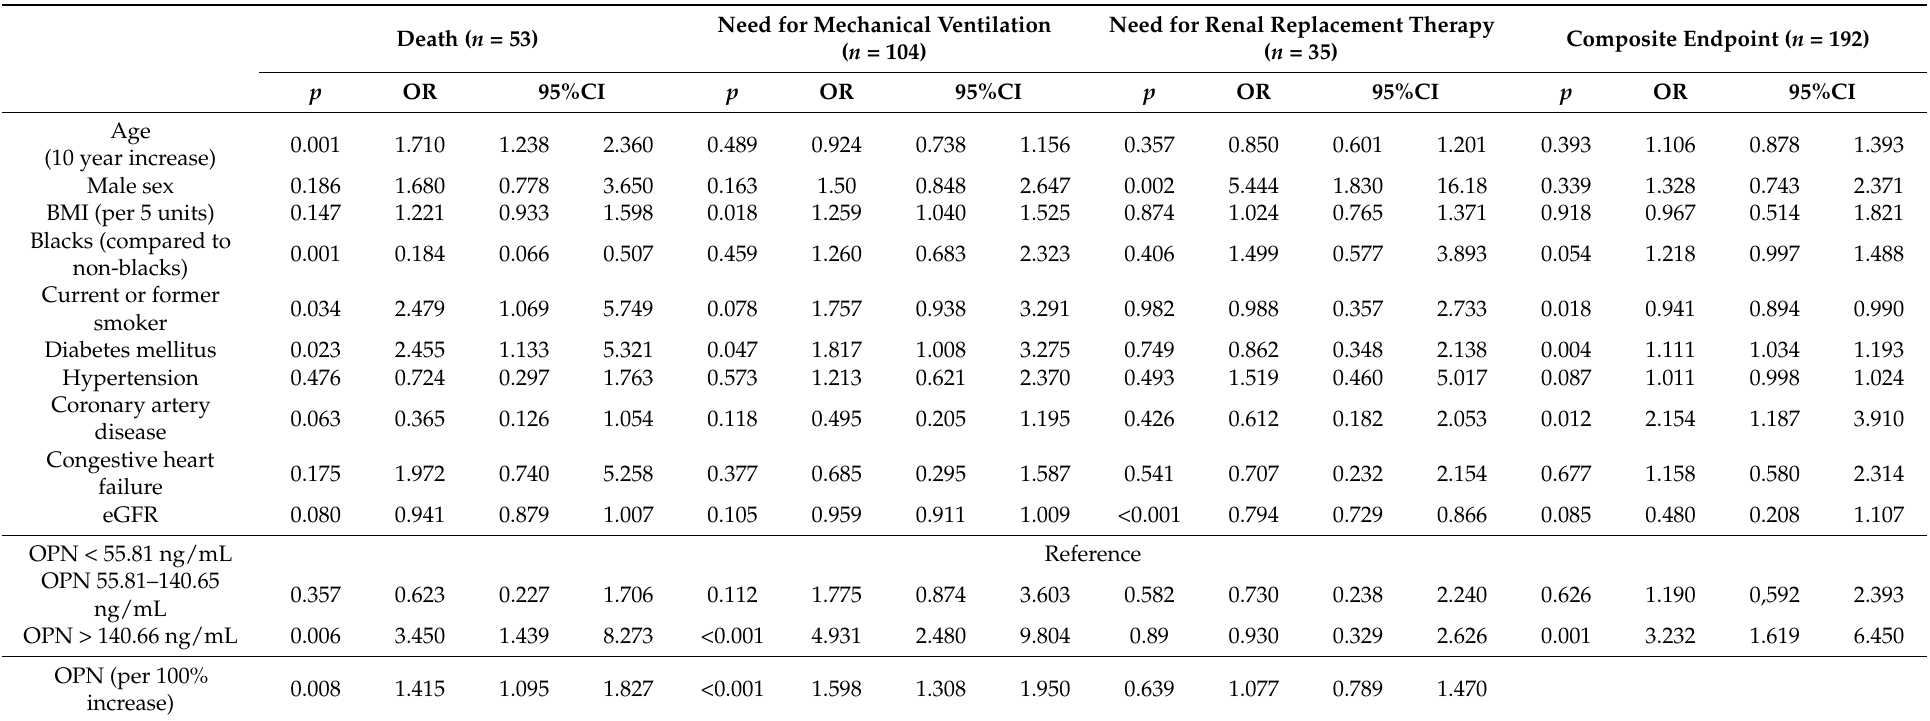
Table 4. OPN and clinical characteristics independently associated with in-hospital outcomes of COVID-19